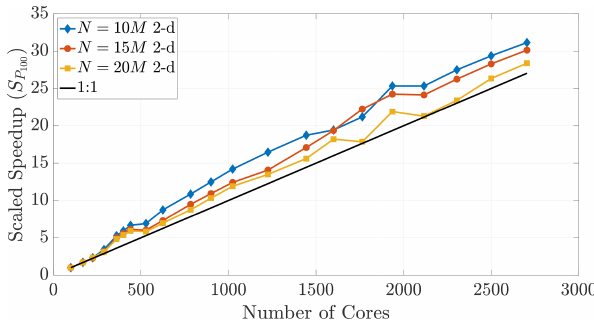
Figure 16. A speedup reference point of T 100 results in super-linear speedup across multiple particle numbers.